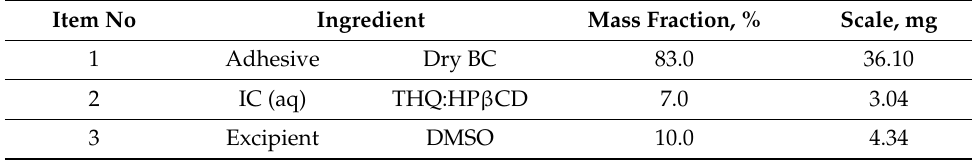
Table 1. Bill of materials for production of THQ:HP β CD-BC wound